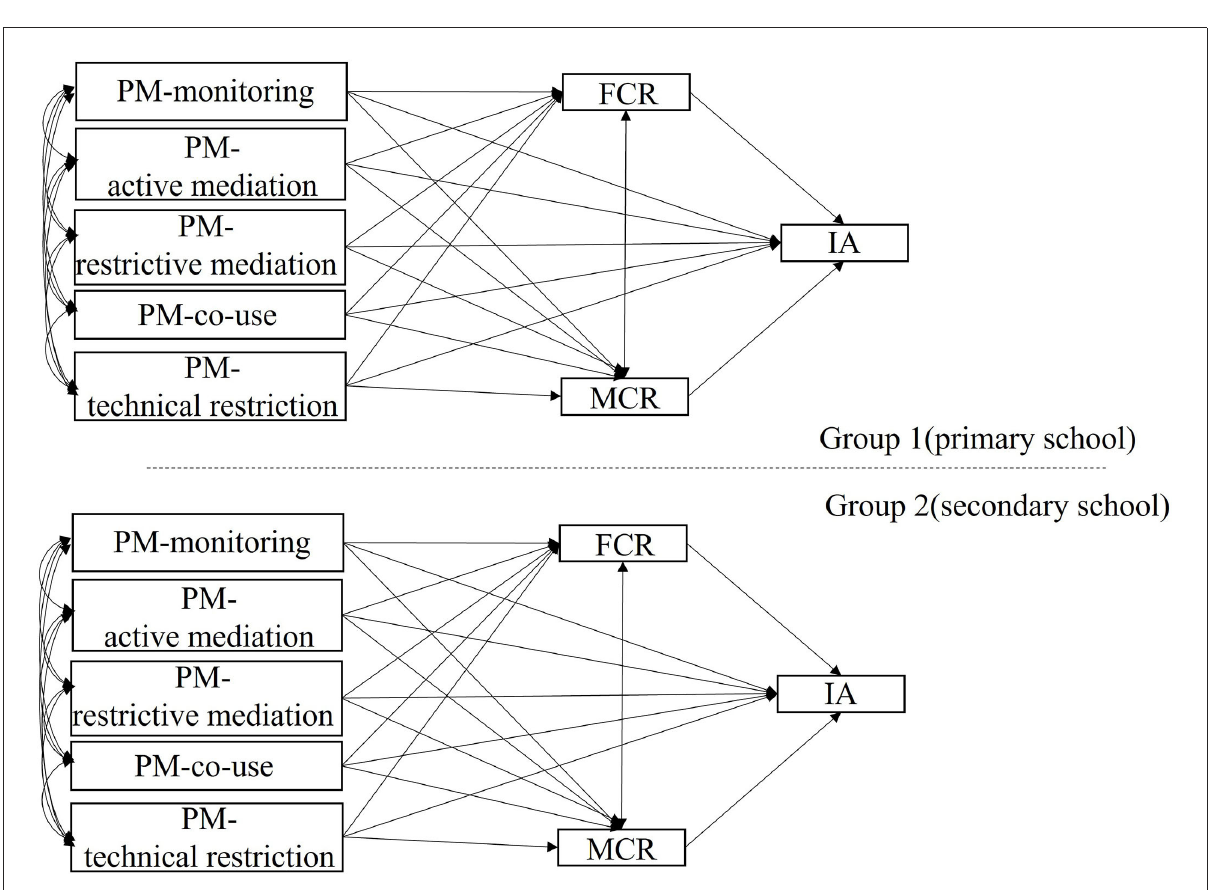
FIGURE4 Schematic representation of multi-group SEM investigating group difference in the indirect effects from PM to IA. Group was set as a categorical variable indicating membership of primary or secondary school groups.